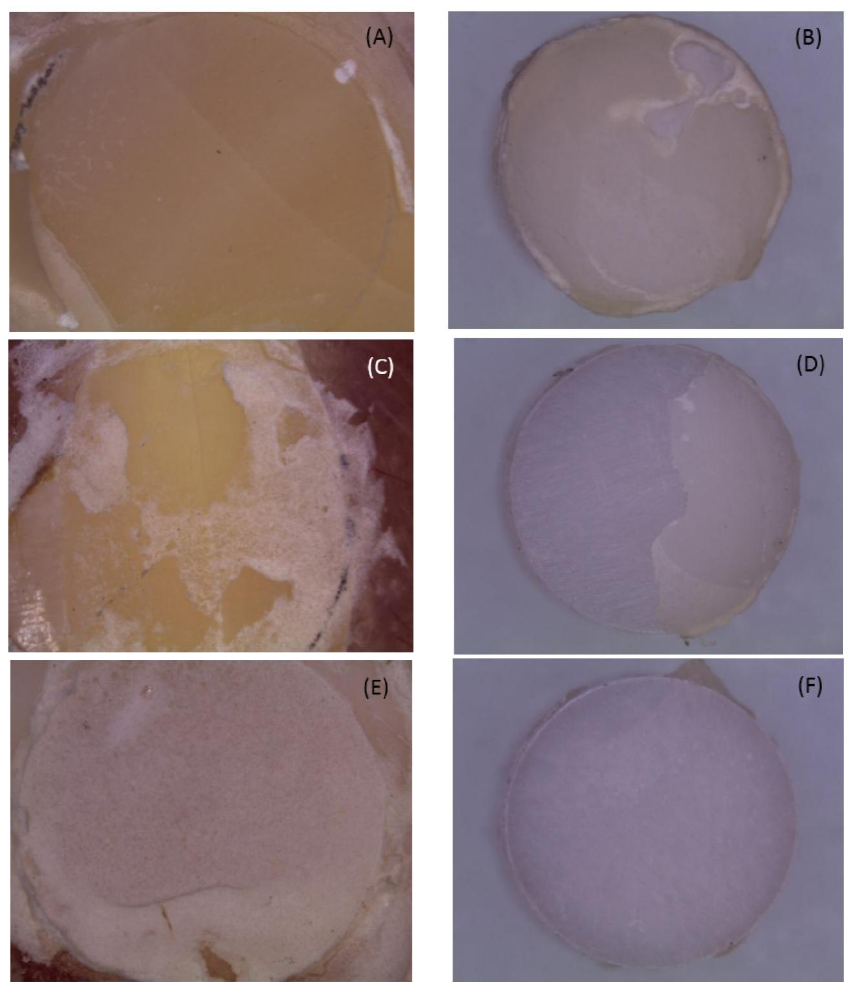
Figure 3. Representative stereomicroscope photomicrographs of the fracture surfaces of enamel and zirconia. ( A , B ) ER (adhesive fracture between enamel and resin); ( C , D ) MM (mixed fracture mode); and ( E , F ) ZR (adhesive fracture between zirconia and resin).